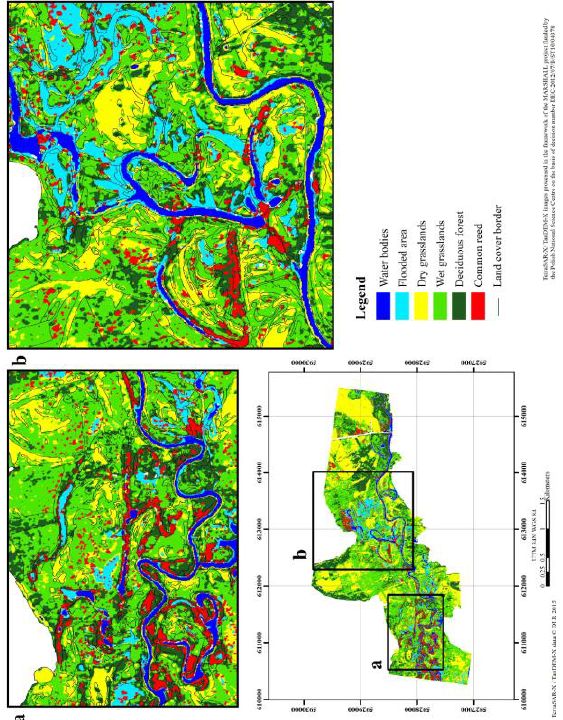
Figure 5. Zooming of parts of the fig.4.